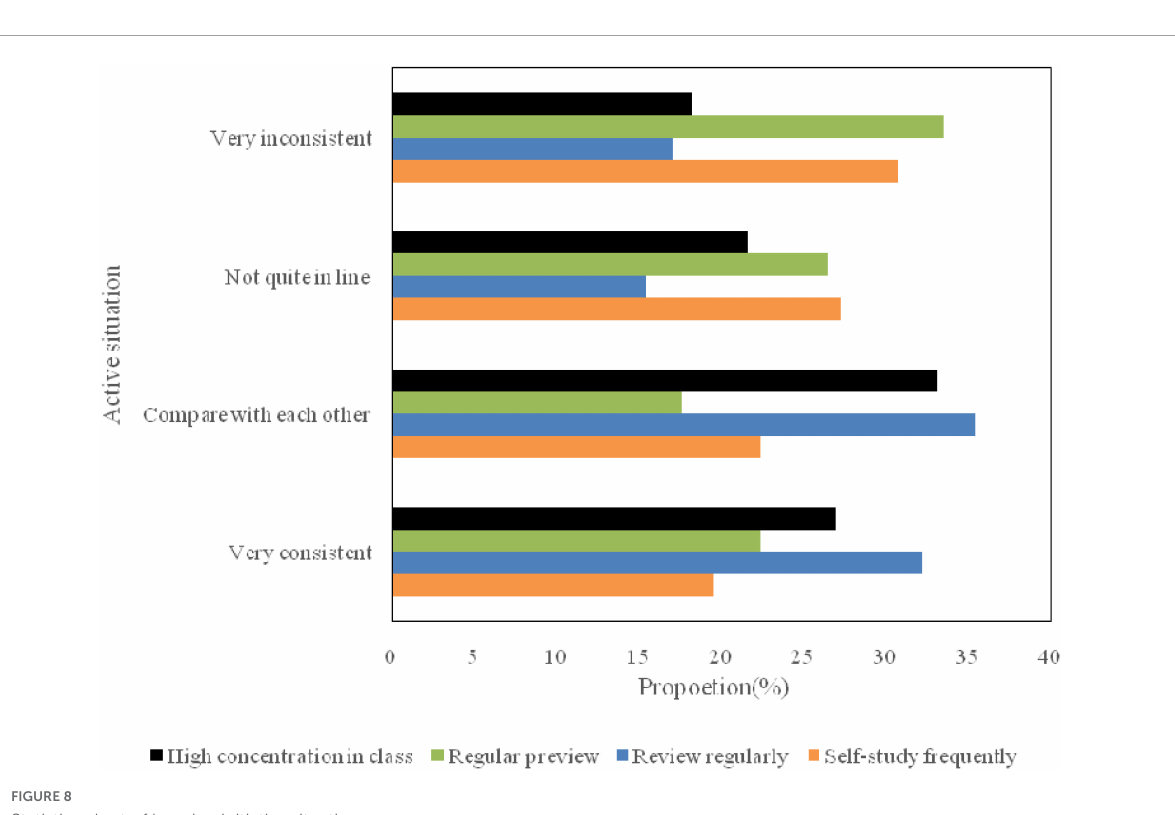
FIGURE8 Statistics chart of learning initiative